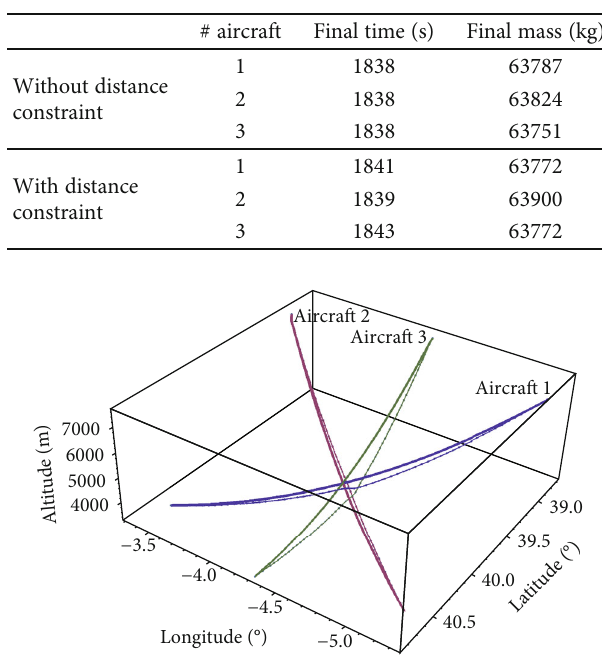
Figure 8: Experiment 2. 3D view of the paths with (thin lines) and without (thick lines) distance-based separation constraints.